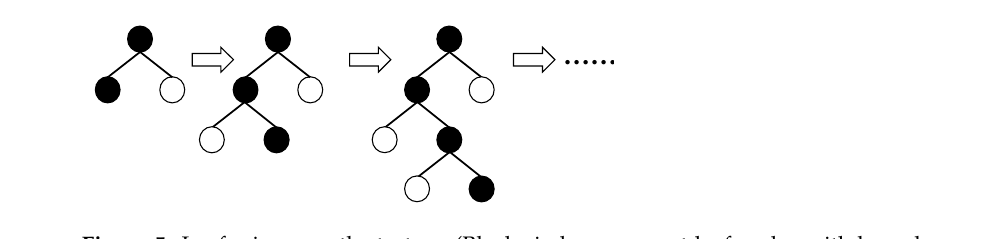
Figure 4. Histogram algorithm.